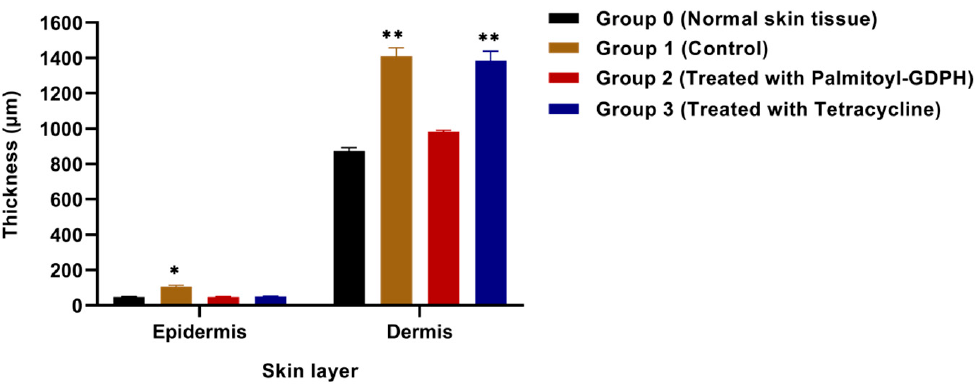
Figure 10. Epidermis and dermis thickness at the end of the experimental period. Data are shown as mean ± SD obtained from triplicate experiments. The asterisks (*) represent significant difference (* p < 0.05) and very significant difference (** p < 0.01) from normal skin tissue (Group